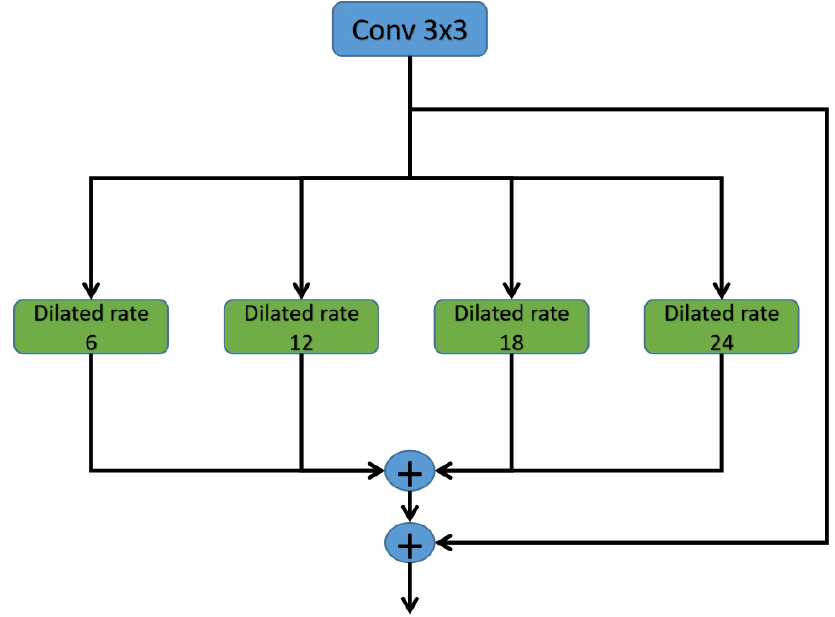
Figure 3. Illustration of